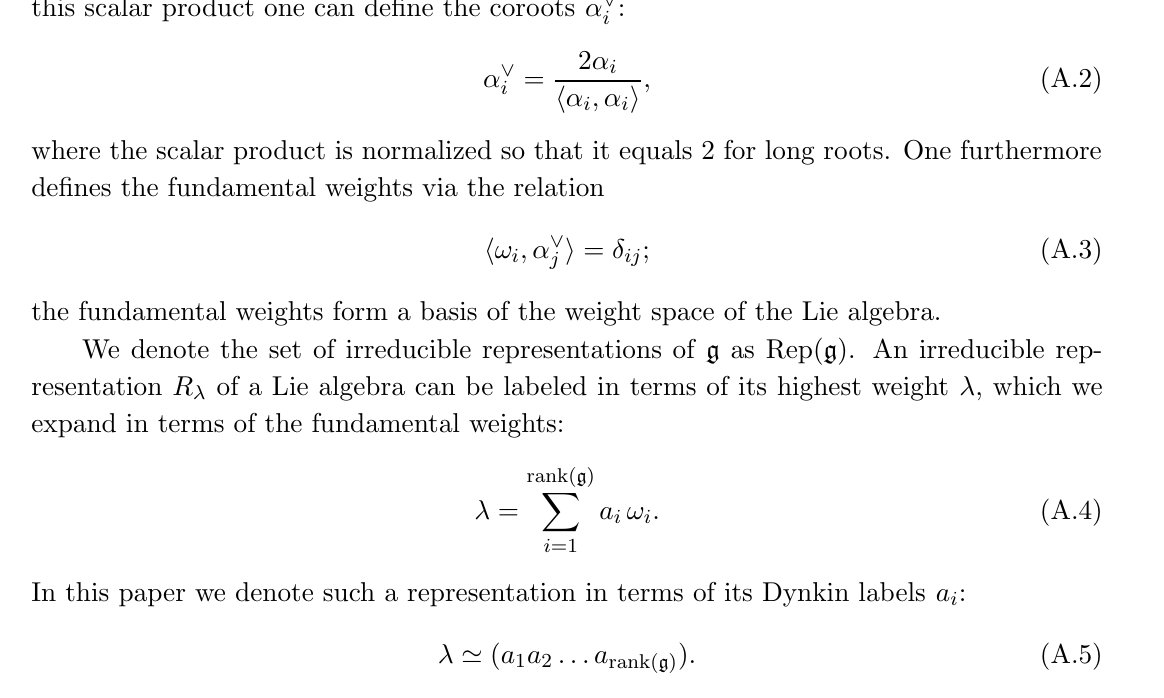
Figure 17. Dynkin diagrams associated to simple Lie algebras. We label the i -th node by ( i; a _ where a _ are the comarks i